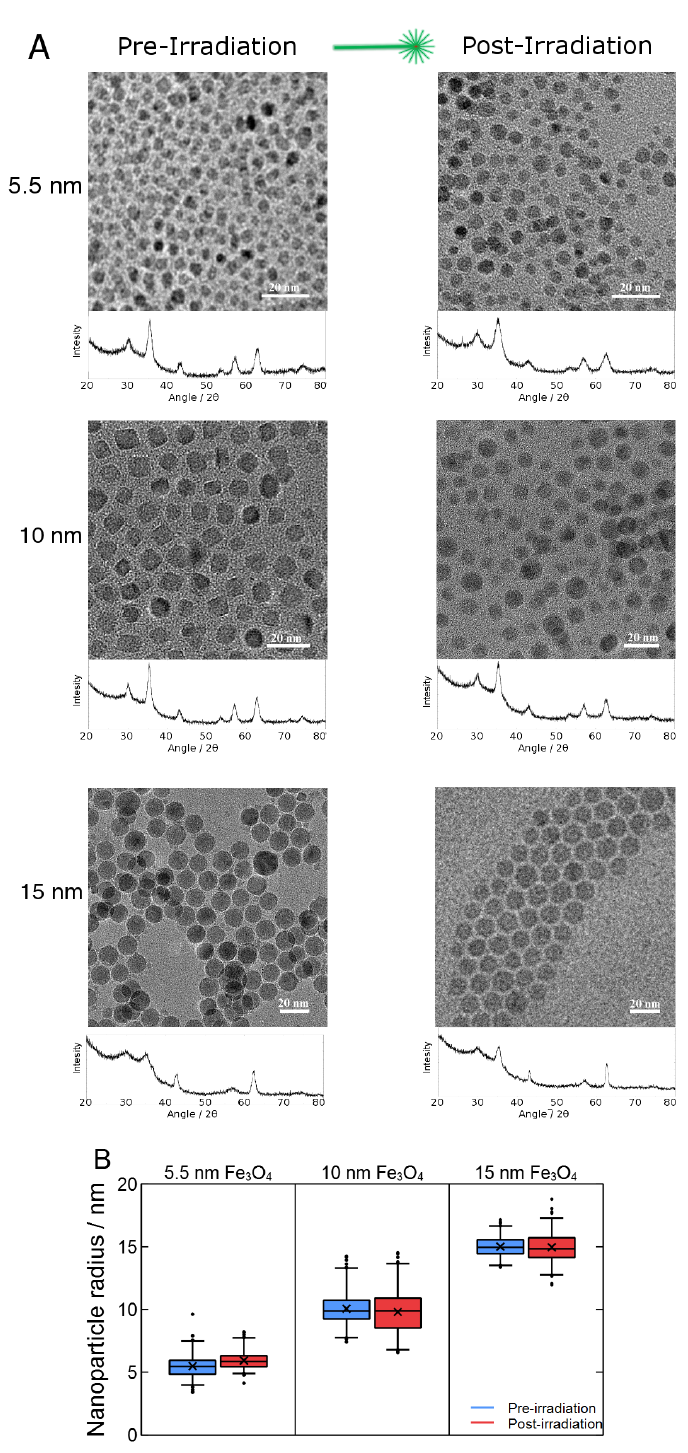
Figure 2. ( A ) TEM images and XRD patterns for magnetite nanoparticles (MNP) synthesized showing geometric and crystalline stability; ( B ) Whisker plots showing various values obtained from TEM images. In these plots, ‘ × ’ indicates the mean size of the particle, while the horizontal line near ‘ × ’ indicates the position of the median size. The top and bottoms of the box show the 25th and 75th percentiles of the sizes, while the whiskers indicate the second and 98th percentiles of the sizes. The individual points are the particle sizes that lie outside these